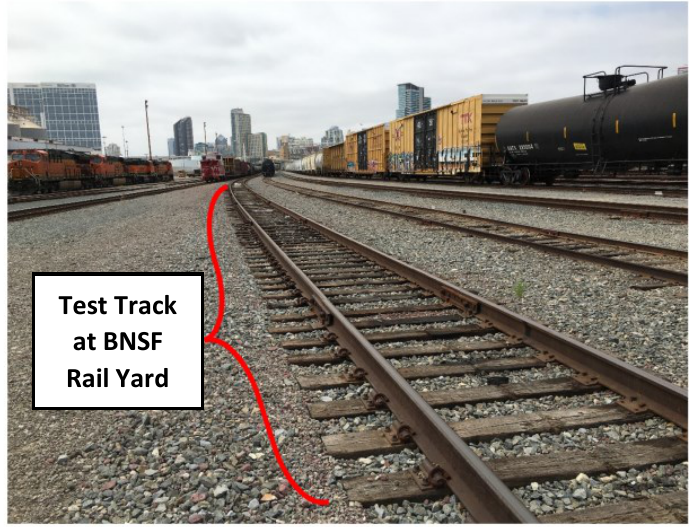
Figure 8. Section of test track at a BNSF rail yard in San Diego, CA, USA.